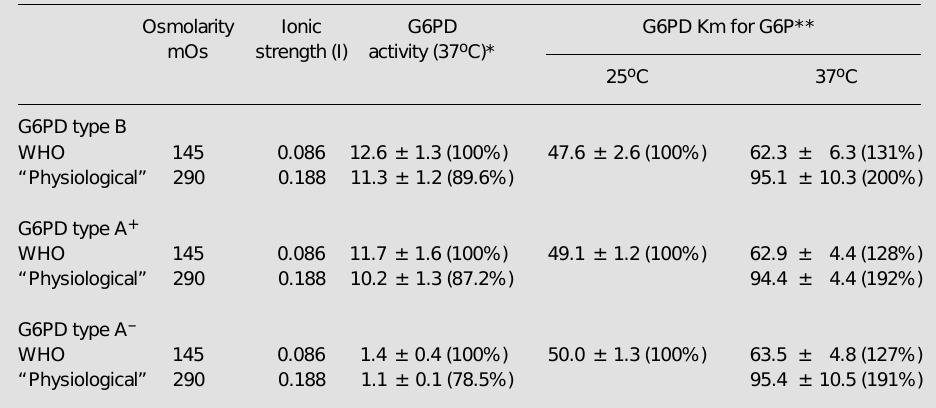
Table 1 - Glucose-6-phosphate dehydrogenase (G6PD) activity and affinity for its substrate under standard (WHO) and “physiological”